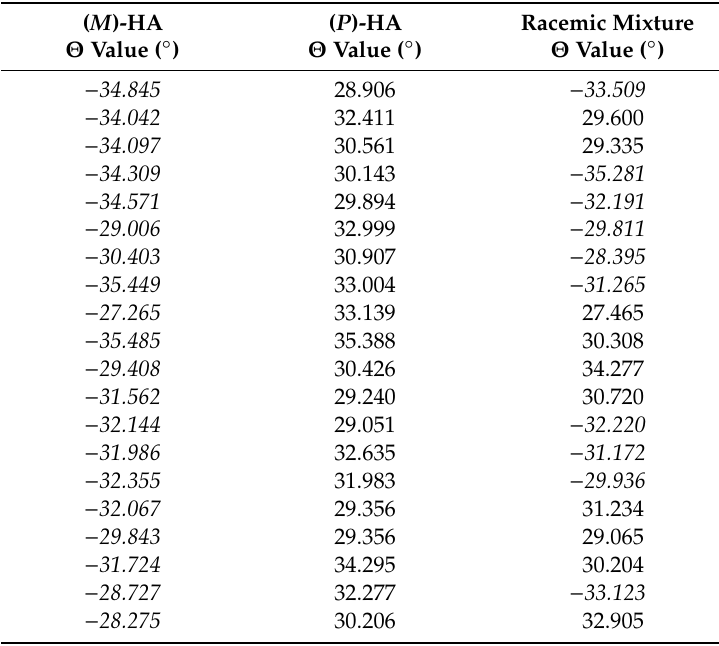
Figure 10. Solvent-accessible surface area colored by the charge of atoms for optimized geometries of double-stranded DNA as data from Protein Data Bank on the left ( a ), of the final optimized geometries of racemic mixtures at low concentration with ( M )-HA / ( P )-HA in a 1:20 stoichiometry in panel ( b ), and at high concentration with ( M )-HA / ( P )-HA in a 1:120 stoichiometry on the right in panel ( c ). The color code is the same as in Figure 6. Table 2. The values of Θ dihedral angles in the optimized geometries obtained at the end of the MD run considering the enantiopure compounds ( M )-HA (negative Θ values in italics) and ( P )-HA (positive Θ values) and the racemic mixture at a low